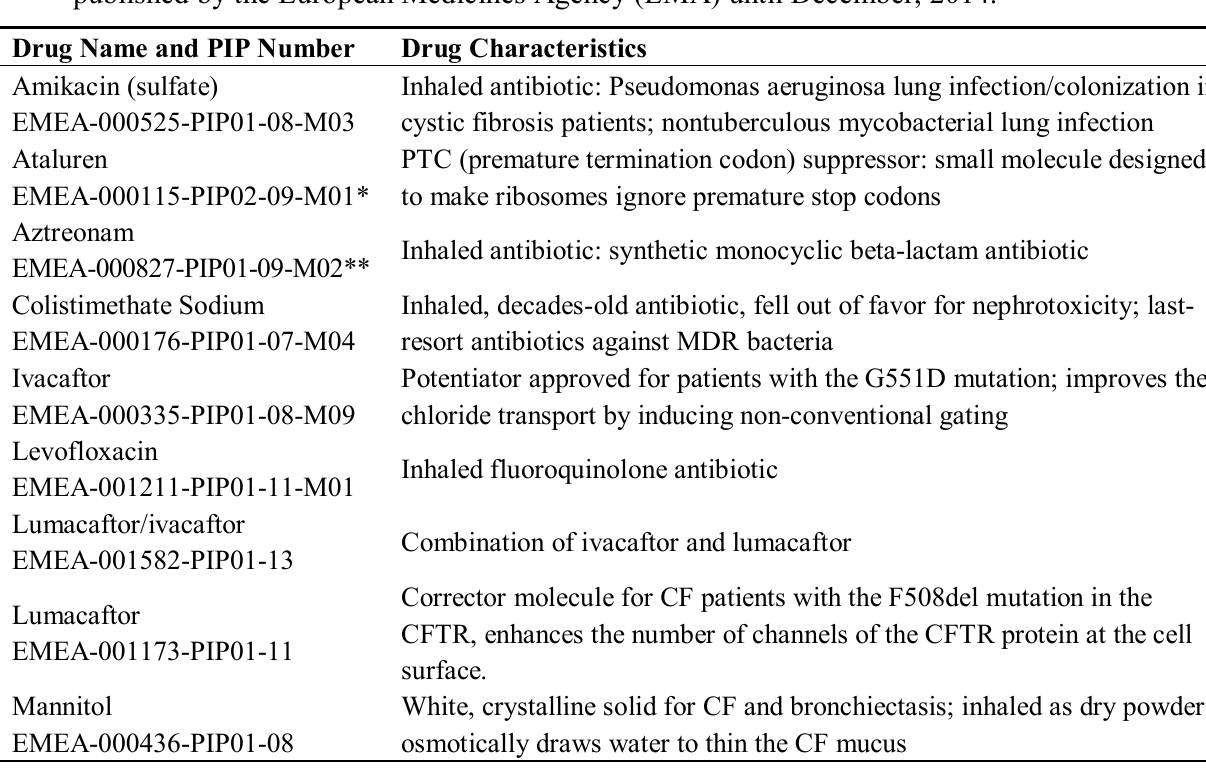
Table 1. Overview cystic fibrosis (CF) pediatric investigation plan (PIP) decisions published by the European Medicines Agency (EMA) until December,